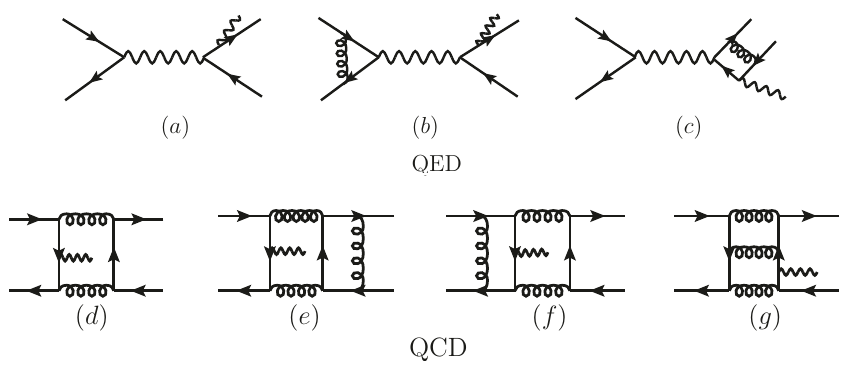
Figure 1 . Some representative Feynman diagrams for Υ → η c ( χ cJ ) + γ . ( a ) corresponds to the LO QED contribution, ( b ) and ( c ) correspond to the NLO QED contribution, ( d ) corresponds to the LO QCD contribution, and ( e )-( g ) correspond to the NLO QCD contribution. The Feynman diagrams are drawn by JaxoDraw